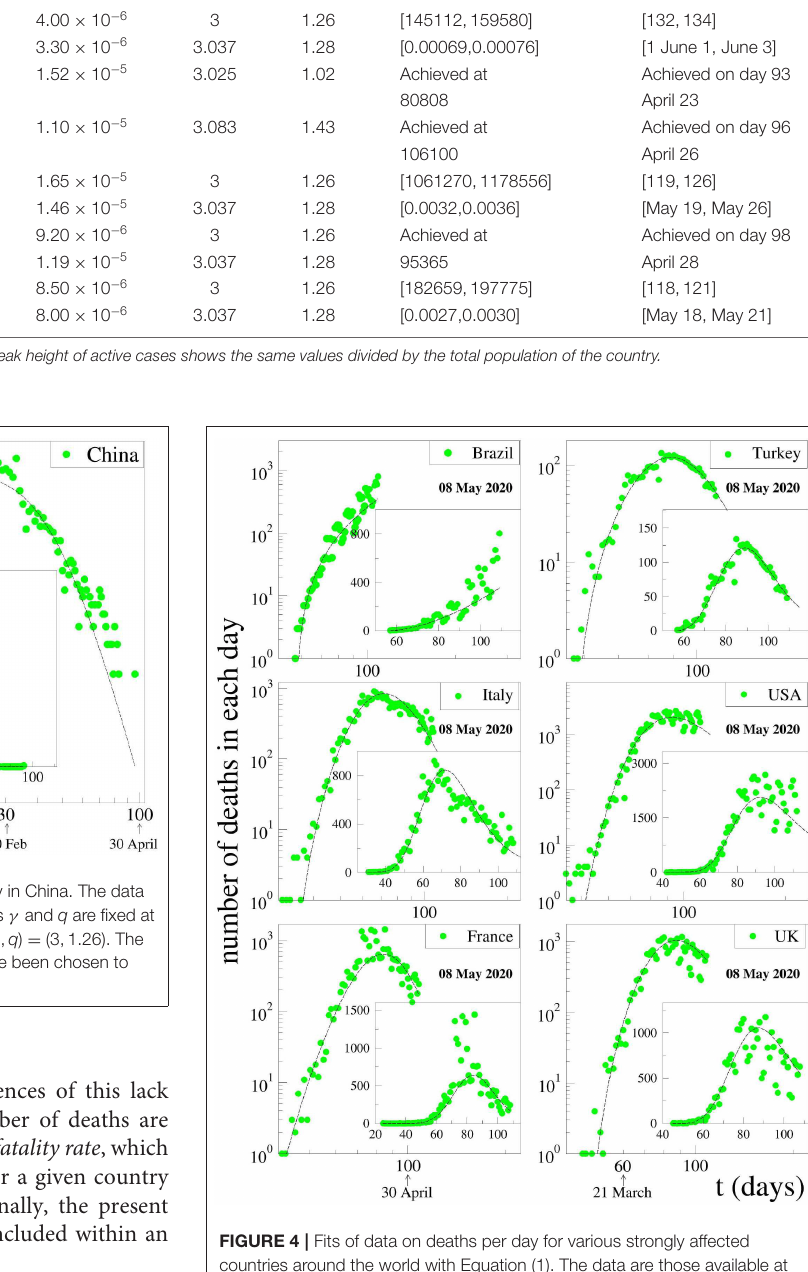
TABLE 1 | The values of the parameters and predictions for the maximum number of active cases and for the day at which the maximum will be achieved. γ and q parameters are fixed at China’s values if peak has not yet been achieved Country Prediction interval Prediction interval of peak height of peak day